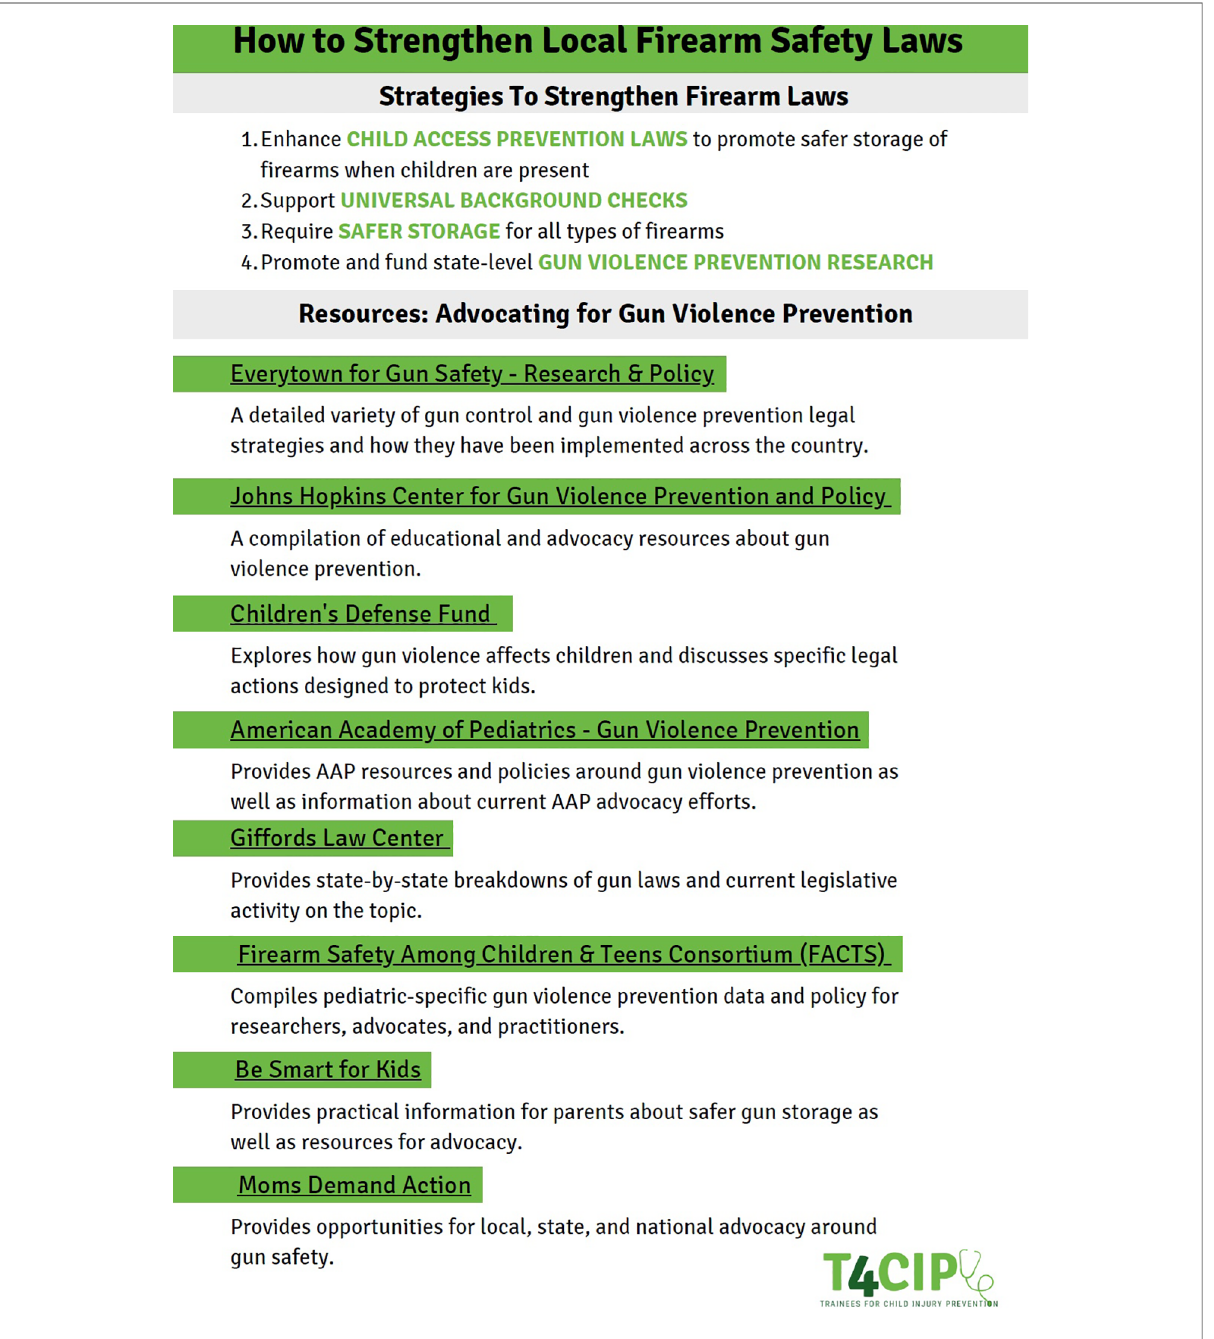
FIGURE 2 First policy “ Guide ” : local/regional advocacy part